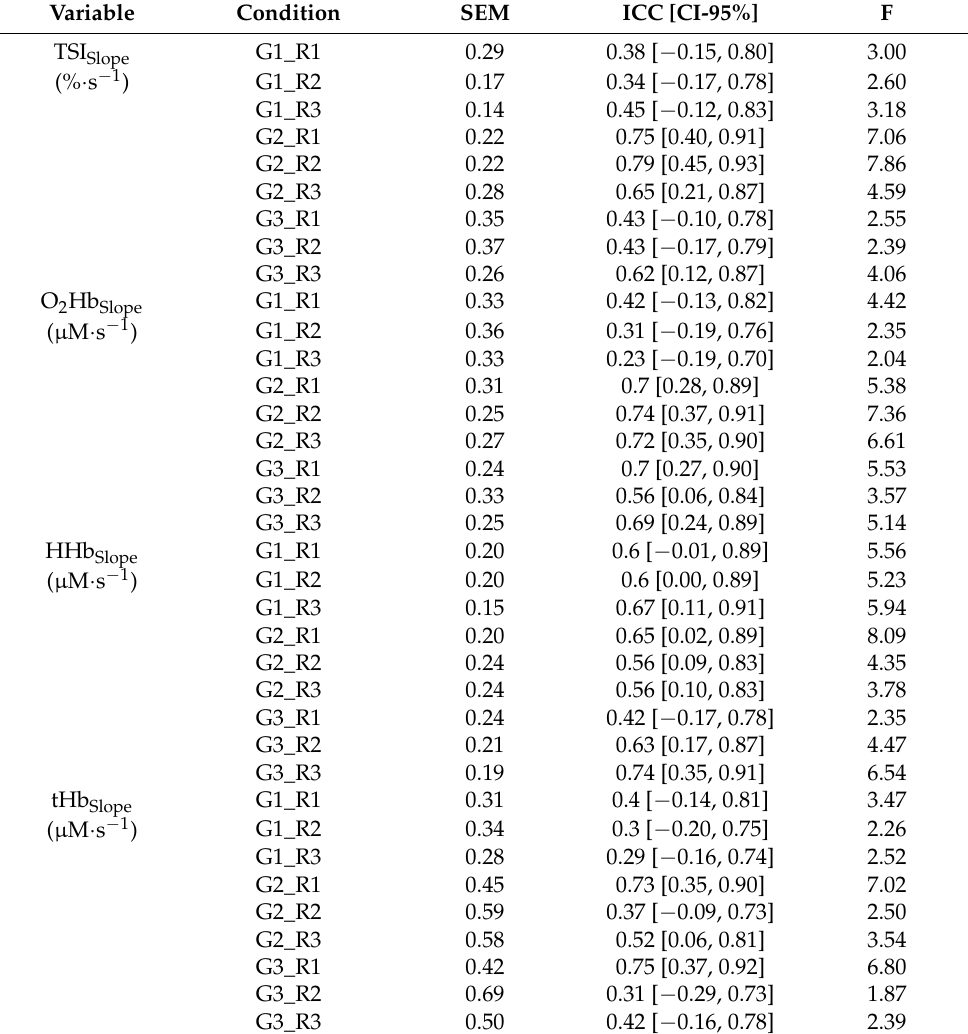
Table 13. Between sessions reliability for the slope of reoxygenation rate. Variable